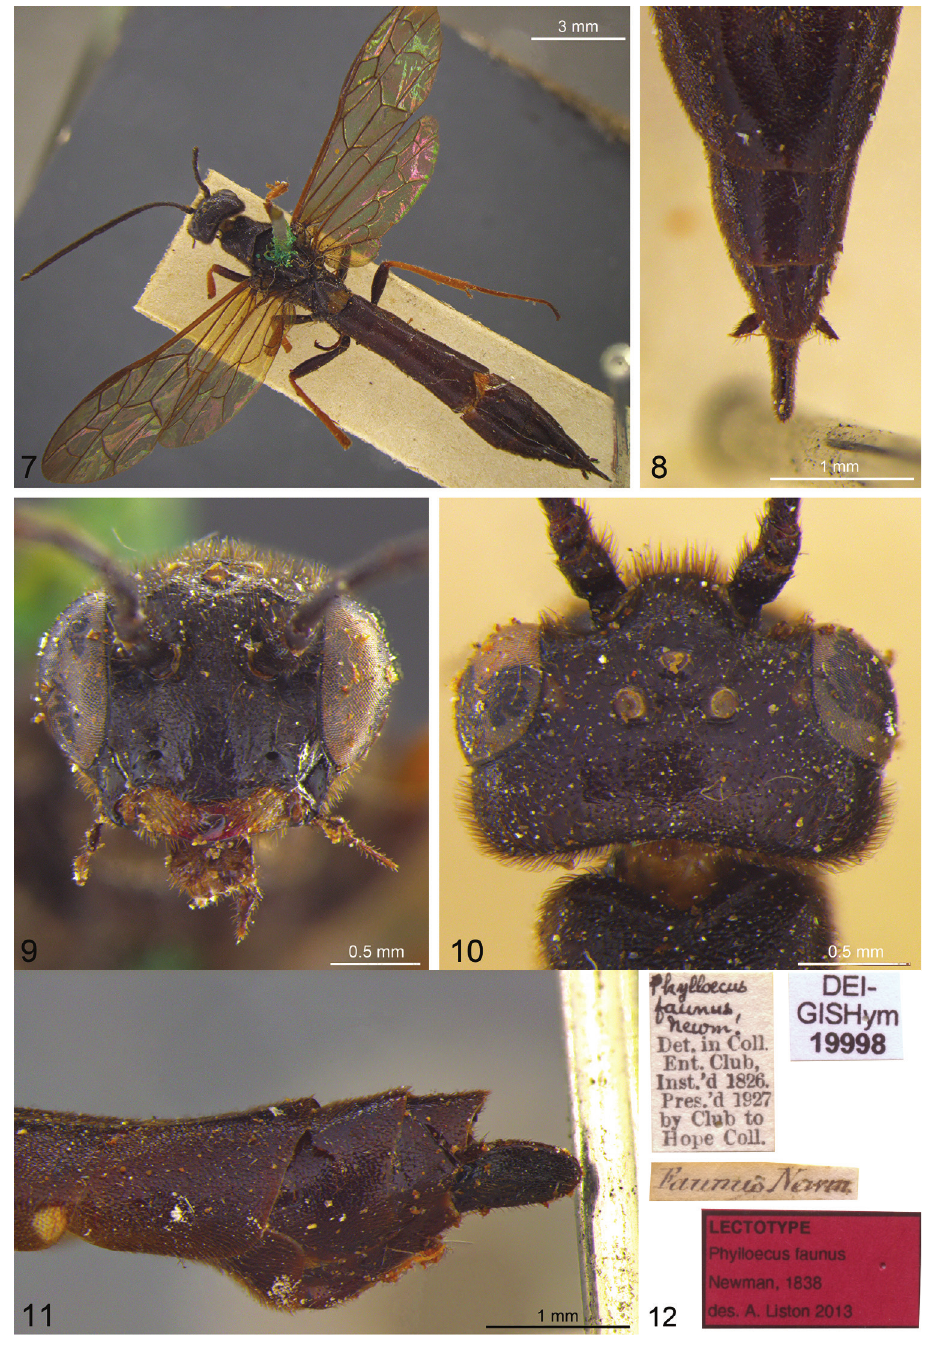
Figures 7–12. Phylloecus faunus Newman, 1838; lectotype. 7 dorsal 8 abdomen, dorsoapical 9 head, frontal 10 head, dorsal 11 abdomen, lateroapical 12